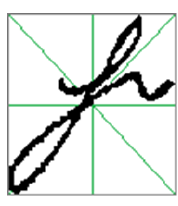
Fig. 2. Example of segment construction.